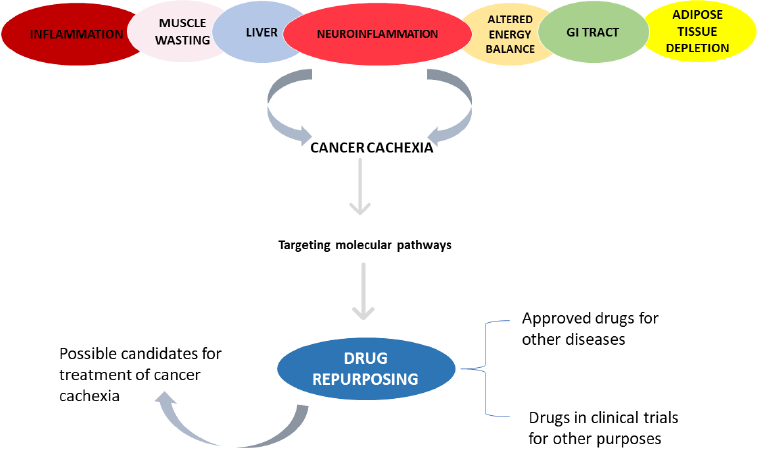
Figure 1. Schematic representation of the paper approach.